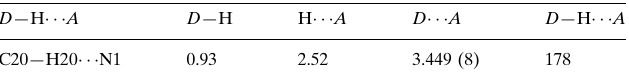
Hydrogen-bond geometry (A˚ , (cid:2)